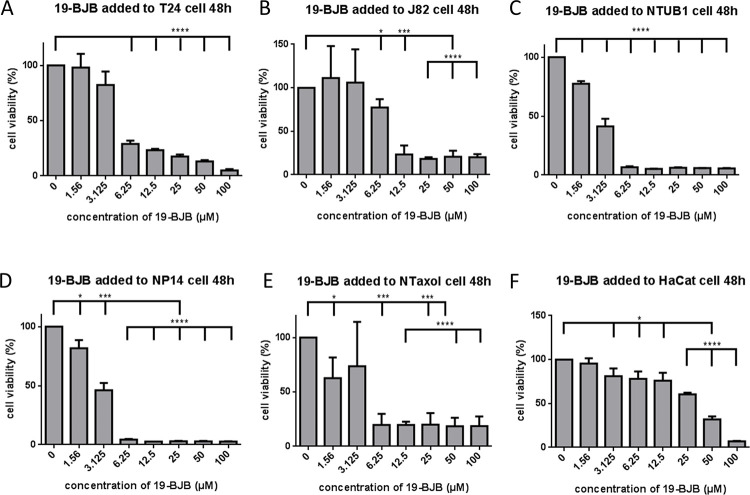
Effects of 19-BJB on cells viability in T24 (A), J82 (B), NTUB1 (C), NP14 (D), NTaxol (E), HaCat (F) cells. The cells were treated with different concentrations of 19-BJB for 48 h. The cell viabilities were measured by MTT assay as Table 1. Values are expressed as mean ± SD for triplicate samples and expressed as a percentage of control (set as 100%). * p < 0.05, ** p < 0.01, *** p < 0.001, **** p < 0.0001.